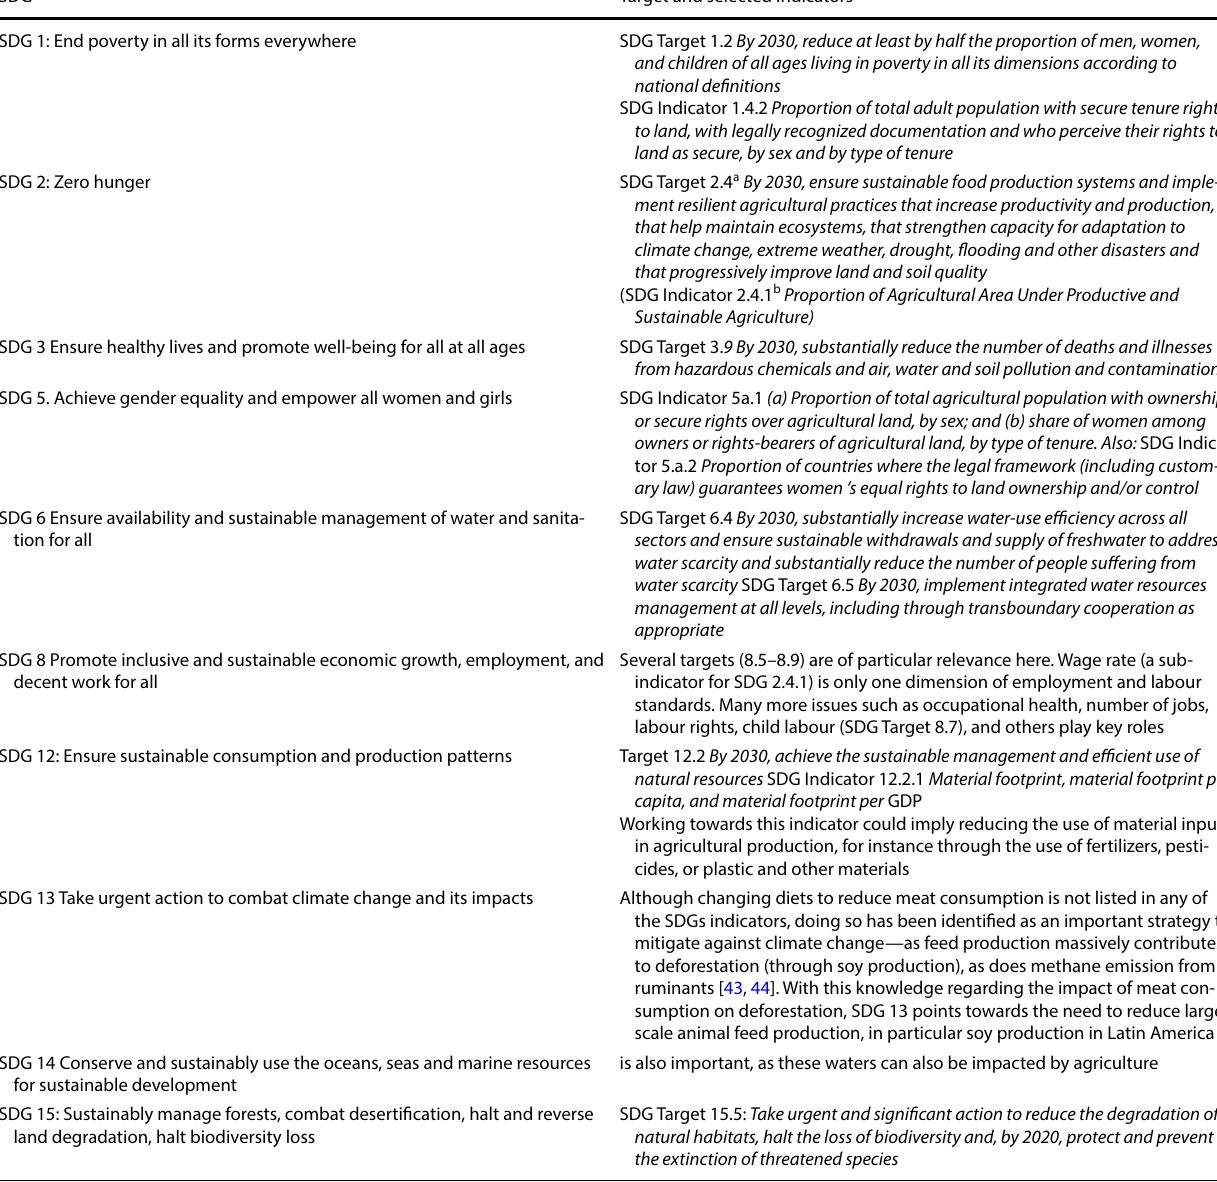
Table 1 List of SDGs and related targets of particular